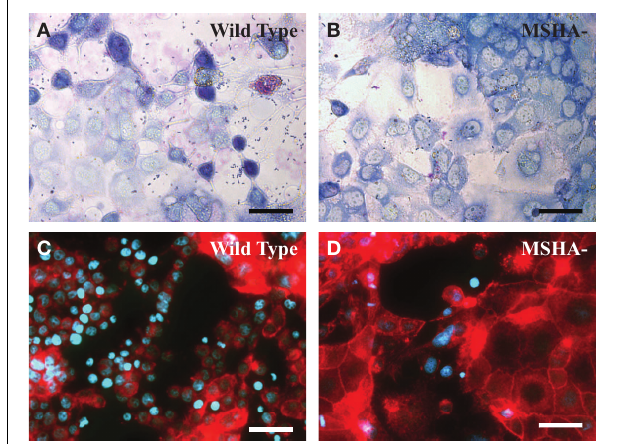
FIGURE 1 | TTSS-associated morphological alterations in intestinal cells require a functional MSHA pilus. (A,B) Giemsa stained co-cutures of wild type (A) or (cid:2) mshAl (B) V. parahaemolyticus and Caco-2 following 1h of incubation and removel of non-adherent bacteria. (C,D) Phalloidin- Alexa 568/Hoechst 33342 stained Caco-2 visualized by epifluorescence microscopy following 2.5h of infection with wild-type (C) or (cid:2) mshAl (D) V. parahaemolyticus. Scale bars represent 50 μ